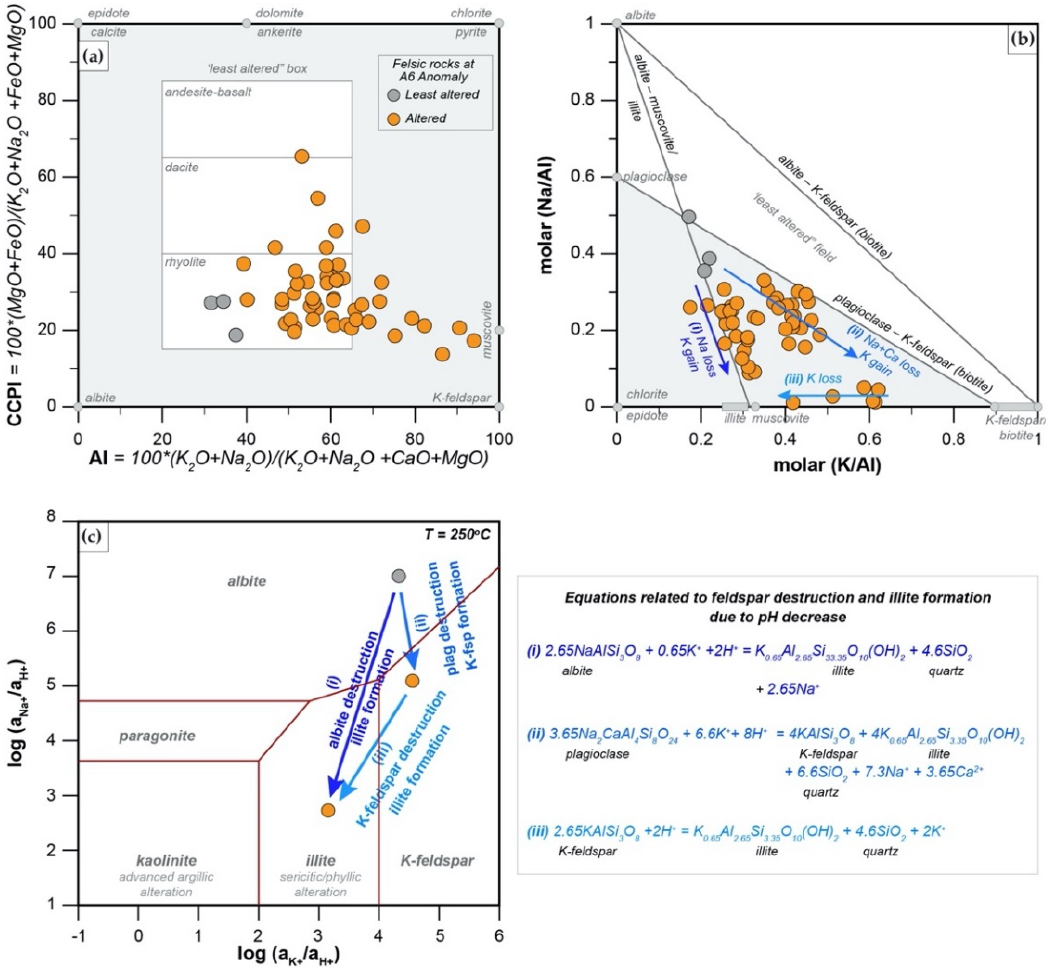
Figure 25. Quantification of processes related to K-Na ± Ca mass changes in altered felsic units of the A6 Anomaly (orange circles), ( a ) Alteration box plot, AI vs. CCPI [98], ( b ) molar ratios of mobile versus immobile element depicting K/Al vs. Na/Al [105]), ( c ) (K + /H + ) activity-(Na + /H + ) activity diagram displaying the processes related to feldspar destruction in the felsic units of the A6 Anomaly at 250 °C, phase diagram modified after [119] with thermodynamic data of [120], equations depicting processes (i) to (iii) highlighted in ( b , c ) are given in the lower right. See text for details.